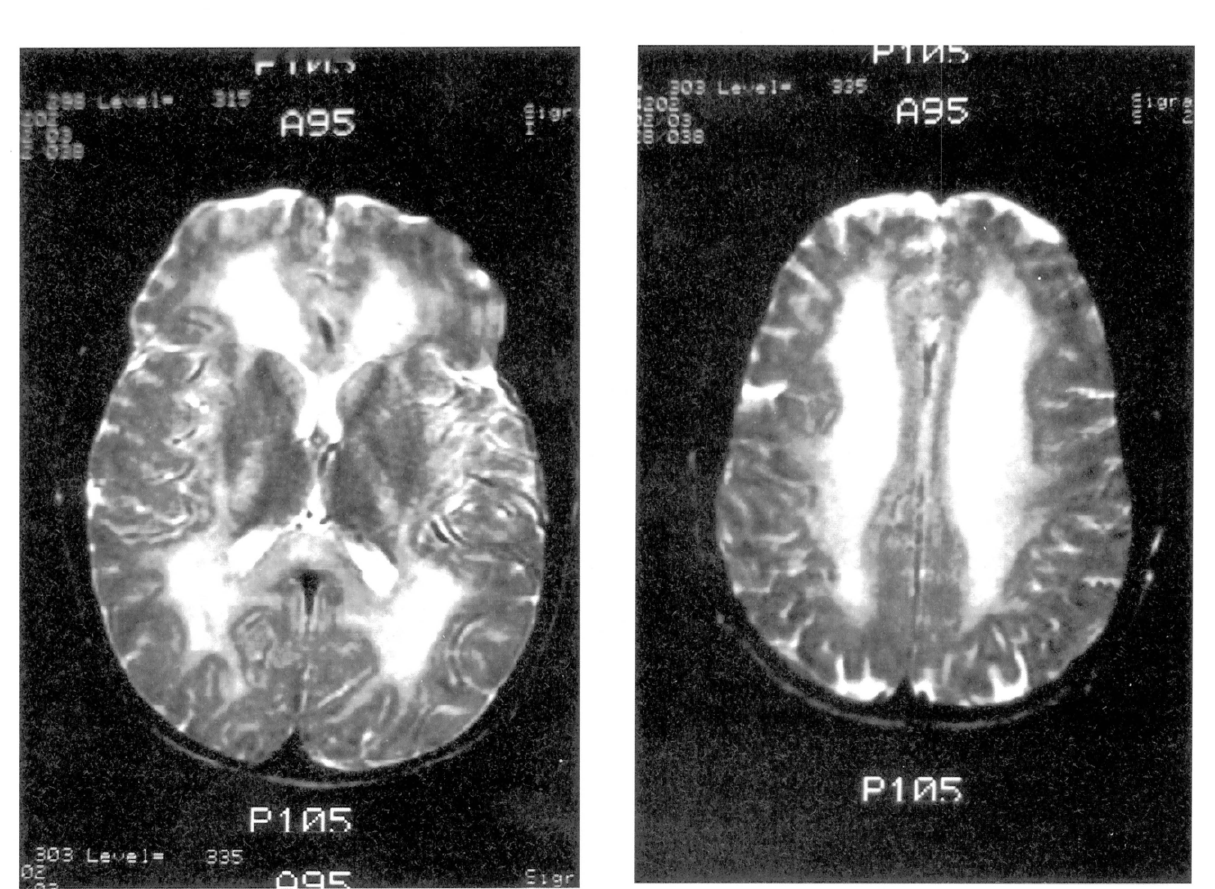
FIG. 1. Magnetic resonance images show extensive. confluent hyperintensities involving cerebral white matter on the long TR sequences. There may be slight involvement of middle cerebellar peduncle and posterior limbs of the internal capsules. The globi pallidi did not appear abnormal.